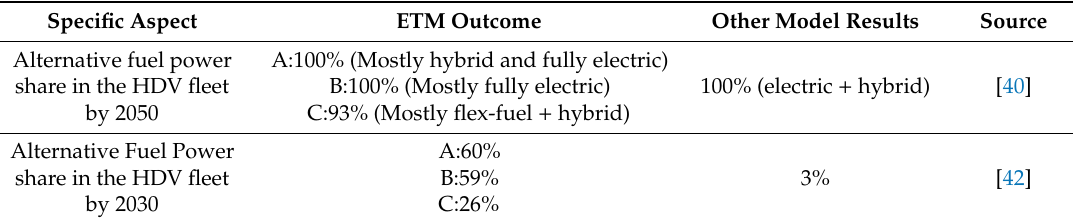
Table 12. Heavy-duty vehicles: ETM vs. other model